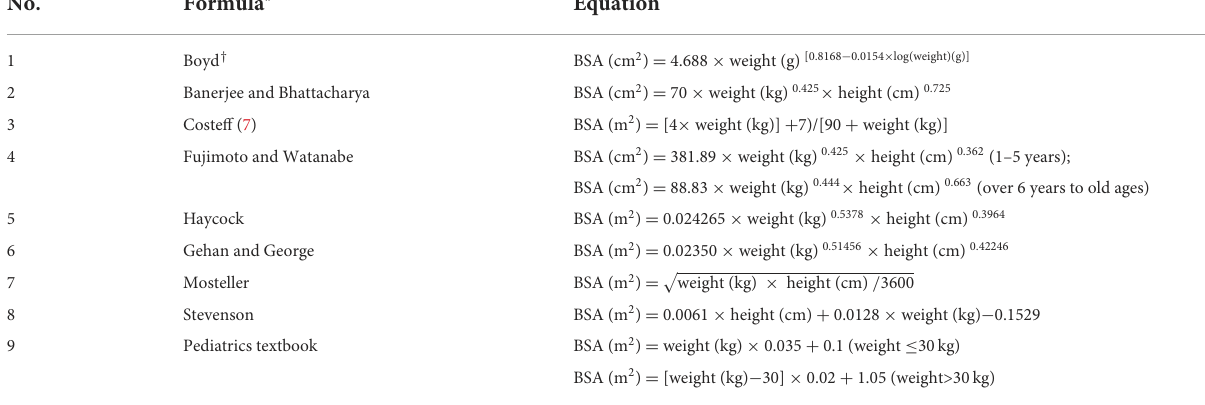
TABLE 1 The empirical BSA formulas used in this